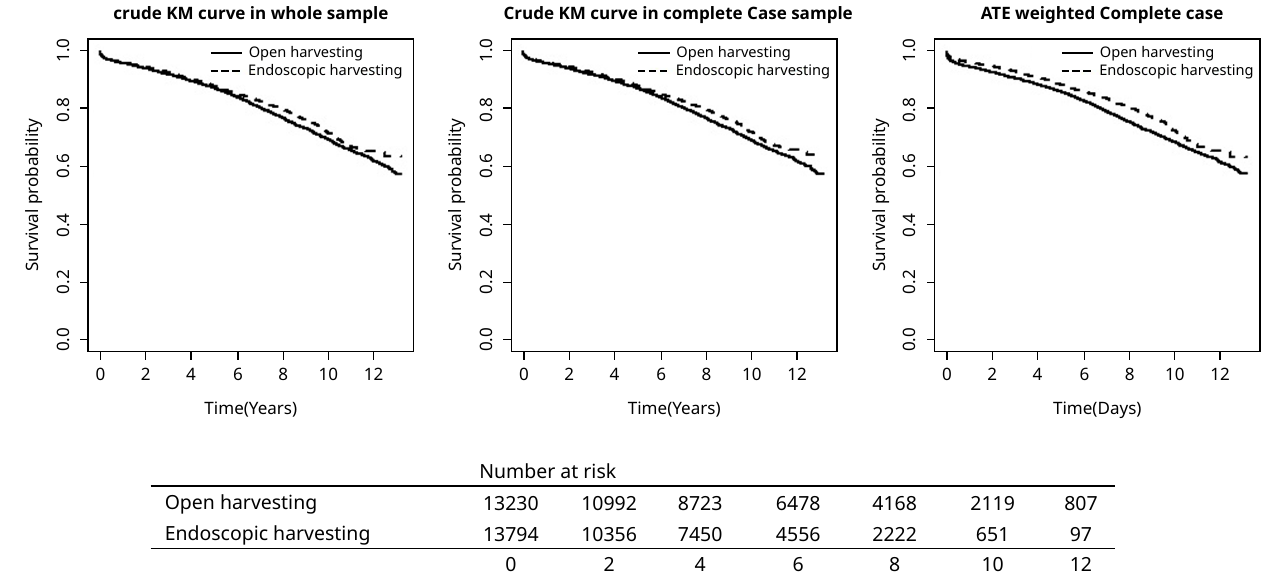
Figure 2. Kaplan-Meier survival curves for the study lower and upper 1% weights was 0.837 (0.778, 0.900). There seem to be a slight bias for unmeasured confounder, but nevertheless the difference between the two interventions stays significant.